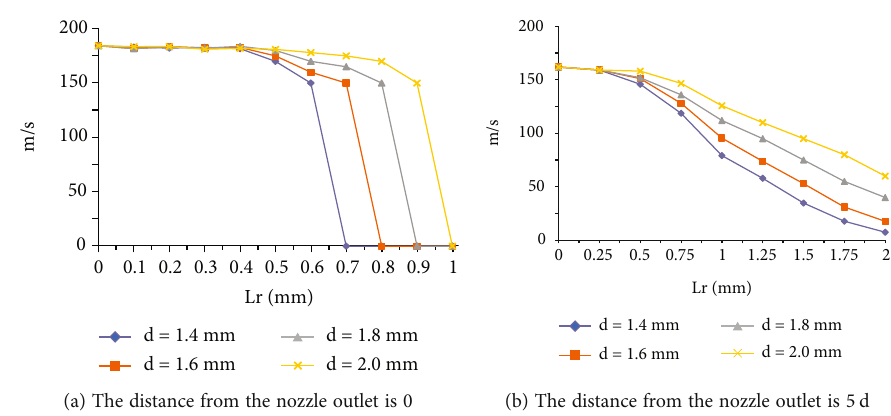
Figure 10: Velocity distribution of the water jet on the vertical axis.